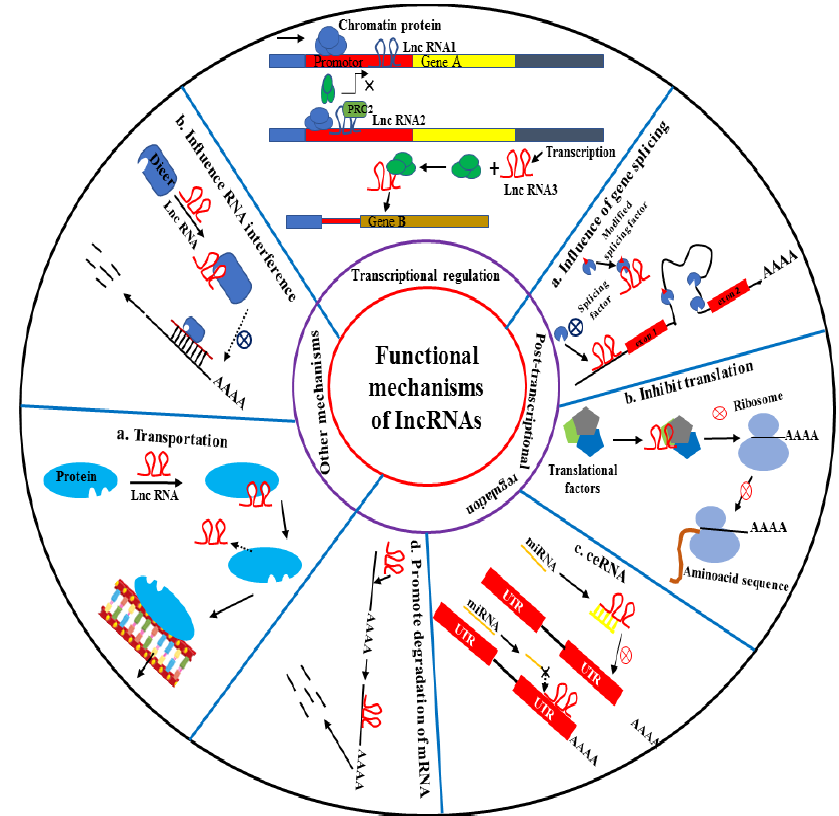
Figure 3. The functions of lncRNAs. LncRNAs perform a key function in gene regulation via a variety of processes, including transcriptional regulation, post-transcriptional regulation, and other mechanisms.